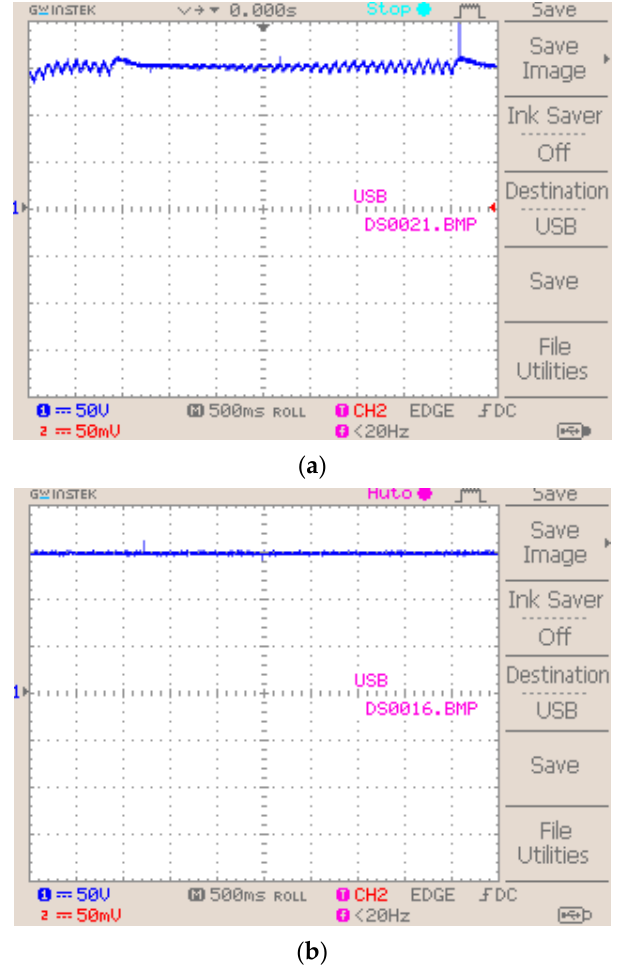
Figure 17. ( a ) Link-voltage with PI controller; ( b ) link-voltage with grey wolf optimization (GWO).